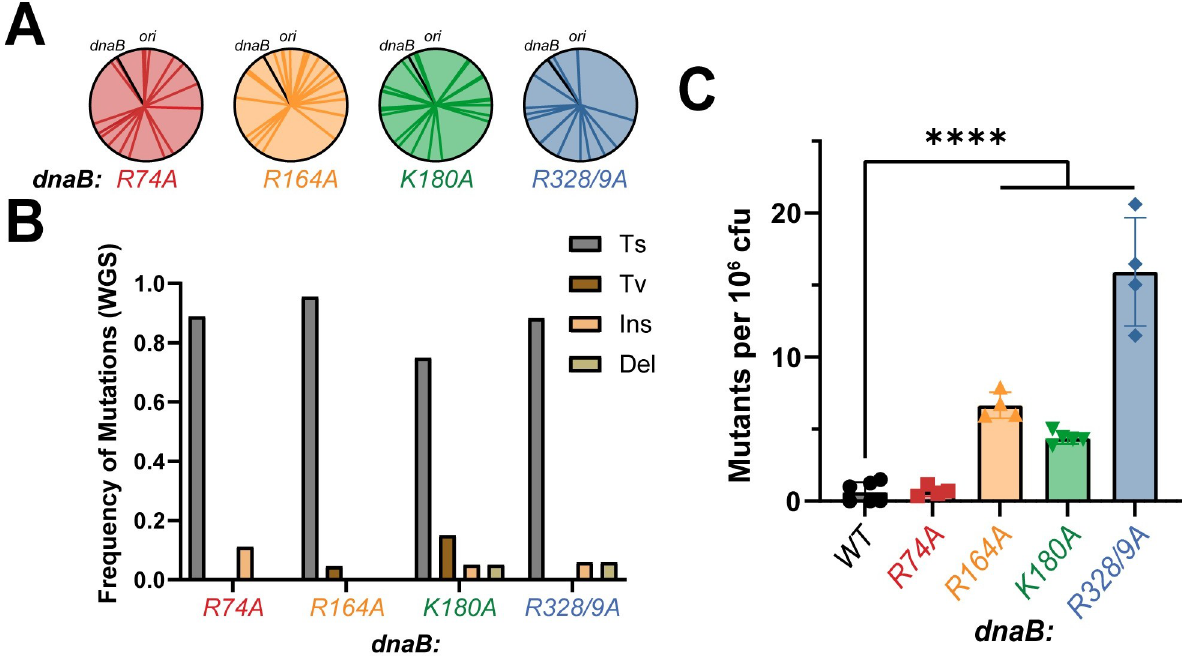
Fig 6. dnaB : muts have increased frequency of mutations. (A) A visual representation of the positional location of mutations detected by two independent whole genome sequencing (WGS) runs mapped on to the circular E . coli chromosome for each dnaB : mut . (B) Quantification of the frequency of mutation types. Ts—transitions, Tv–transversions, Ins–insertions, Del–deletions. Further characterization of Ts and Tv are plotted in S10 Fig and individual mutations are provided in S1 Table. (C) The mutagenicity of each strain was monitored using a rifampicin resistant assay to quantify number of rif R colonies after 24-hour growth in LB. Average number of resistant colonies per 1 million CFU’s are shown ( Eq 6 ). Data is from at least two trials of three technical replicates each (n � 6). Error bars represent ± SD; Black bars indicate statistically significant differences, where p-values are ���� <